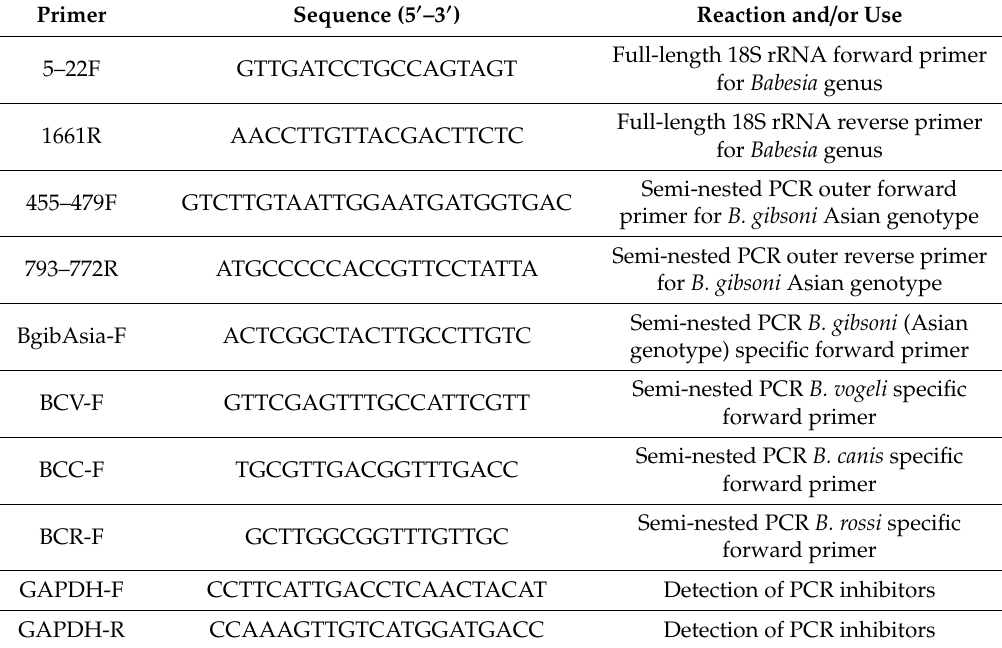
Table 1. Forward and reverse primers used in conventional and nested polymerase chain reaction